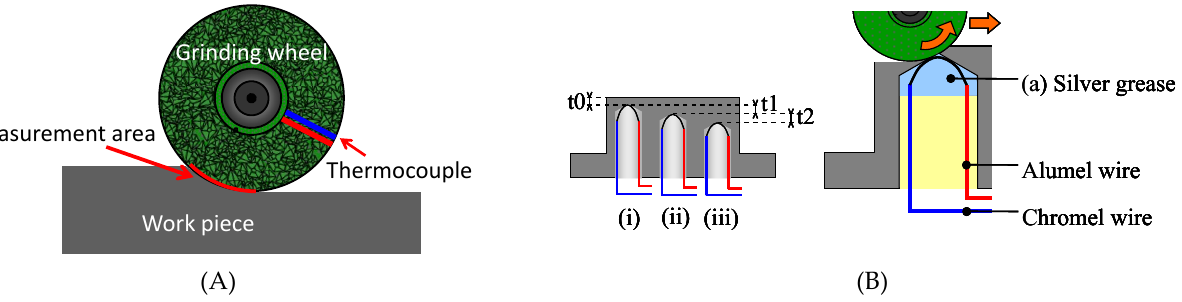
Figure 1. Conventional temperature measurement with the thermocouple. ( A ) Embedded in grinding wheel type [21]. ( B ) Embedded in workpiece type [24].